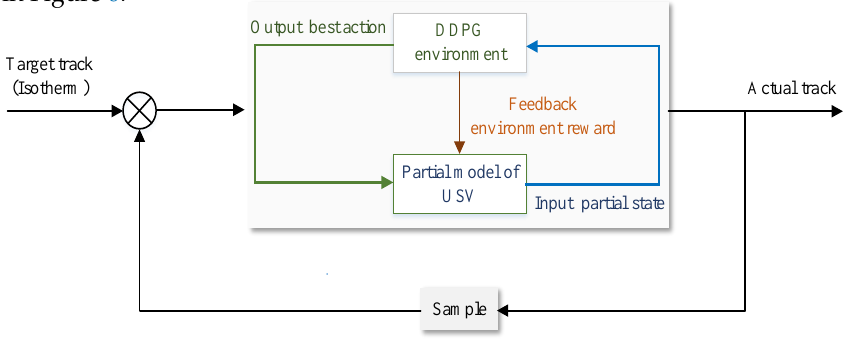
Figure 6. Principle block diagram of USV tracking